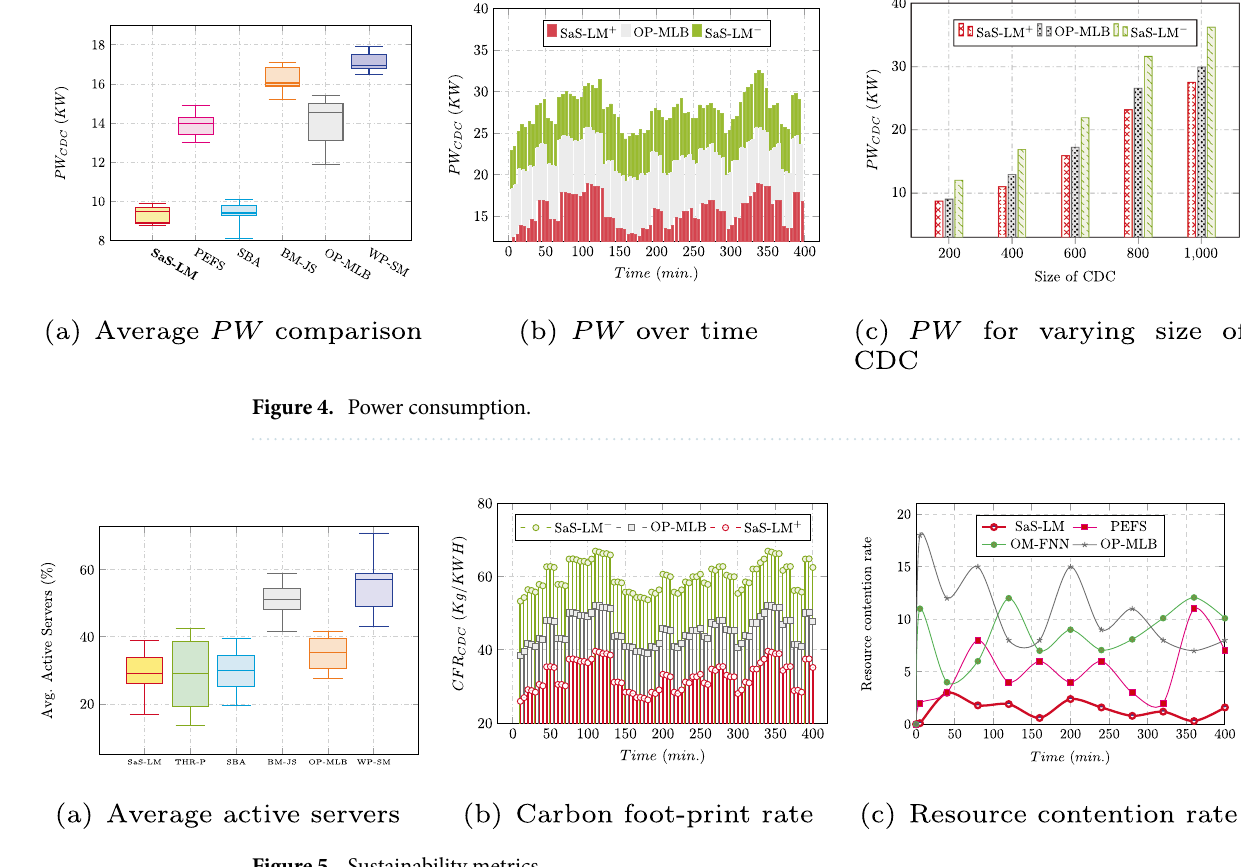
Figure 5. Sustainability